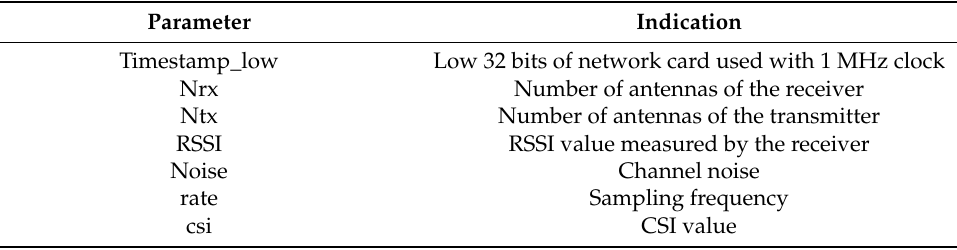
Table 1. Channel state information (CSI) data field table.